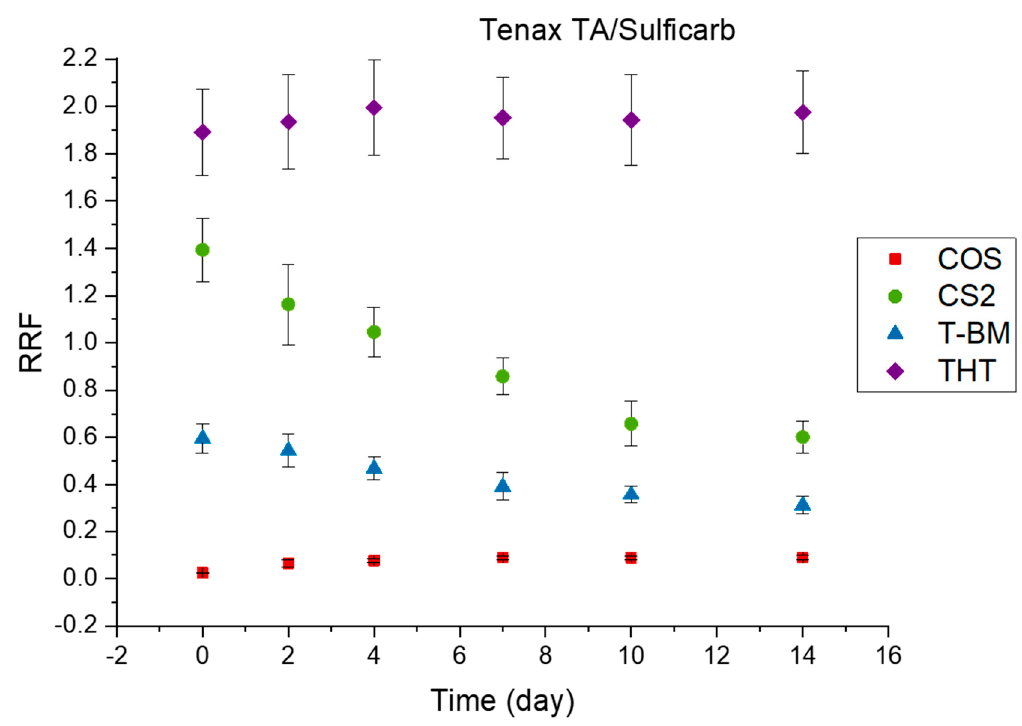
Figure 9. Storage stability of sulphur compounds (~100 nmol/mol) on Tenax TA/SulfiCarb.